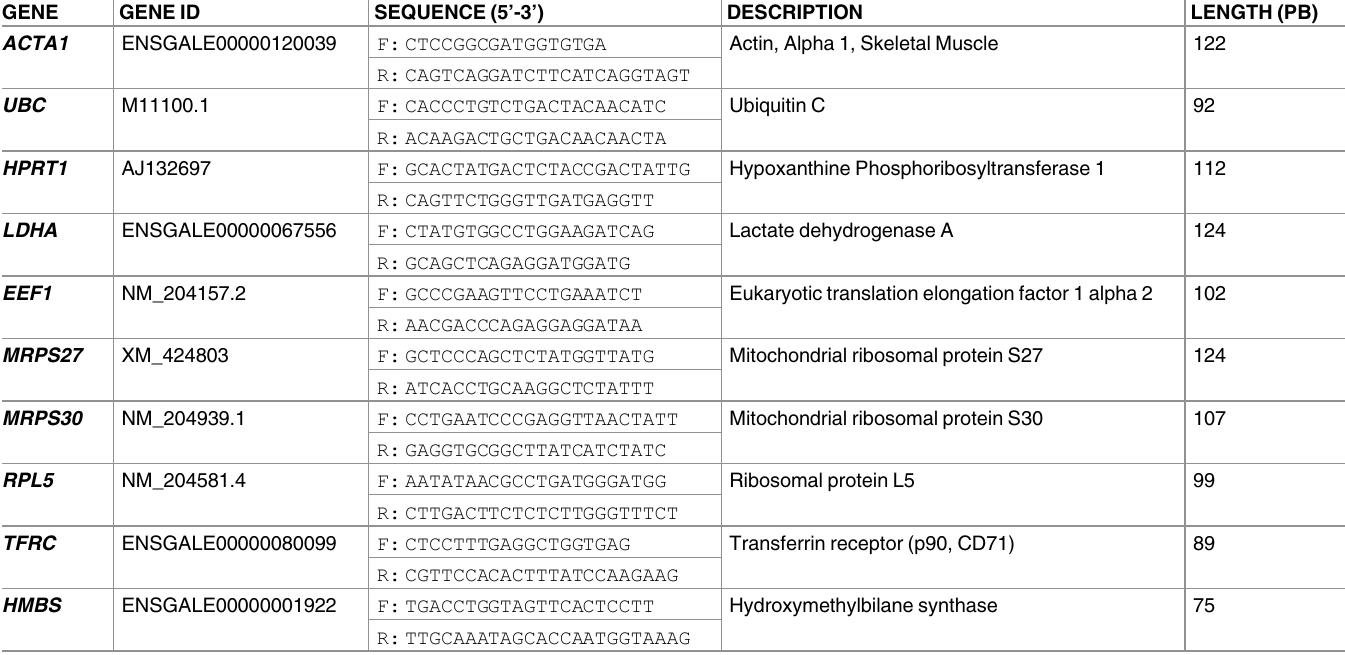
Table 2. Description of Gallus gallus referencegenes, their specific primers used in RT-qPCR analysis and parameters derived from RT-qPCR analysis. All primers were designedby NASCIMENTO et al., (2015).